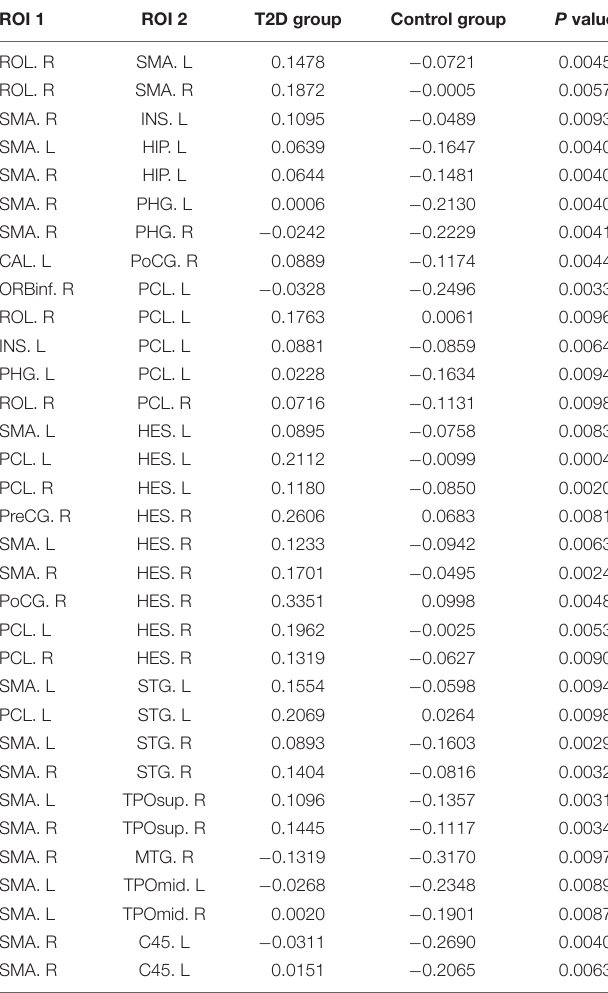
TABLE 2 | The 33 functional connectivities with intergroup differences and their mean connection